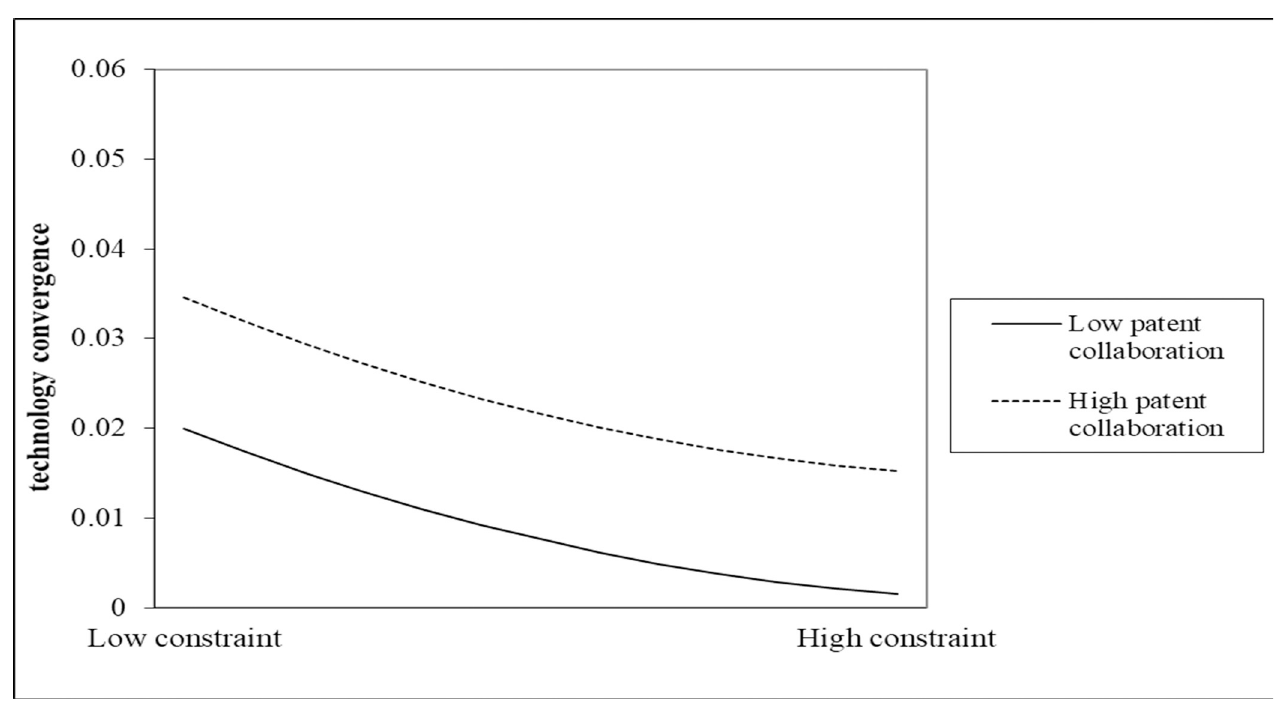
Fig 9. The moderating effect of degree of patent cooperation network for this